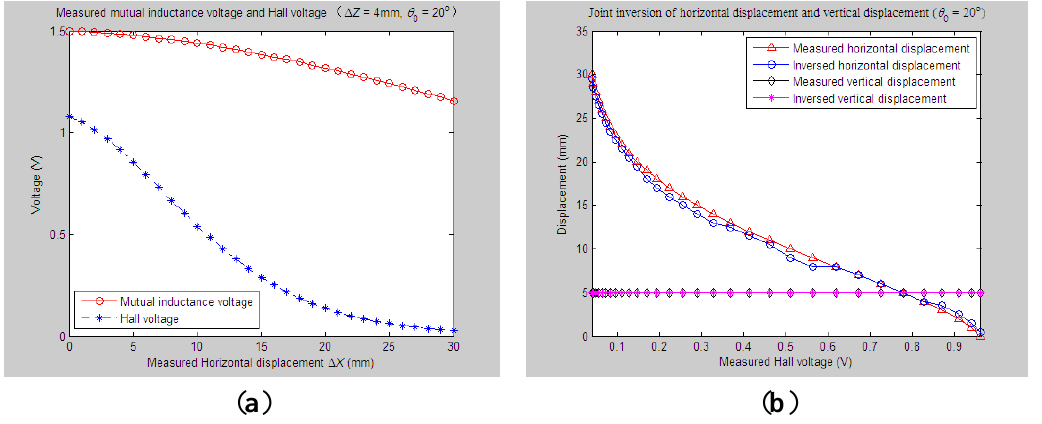
Figure 7. Horizontal and vertical displacement joint inversion results when measured Δ X are changed, while measured Δ Z remain stable ( θ 0 = 20°, Δ Z = 2 mm). ( a ) Measured mutual inductance voltage and Hall voltage; ( b ) inversed horizontal and vertical displacements.